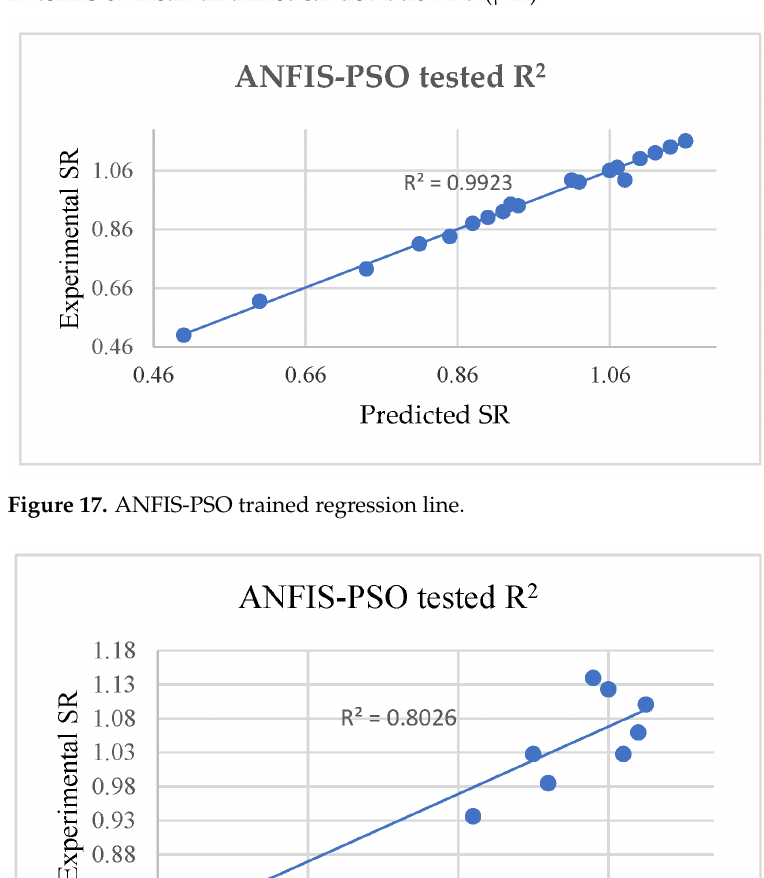
Figure 18. ANFIS-PSO tested regression line .